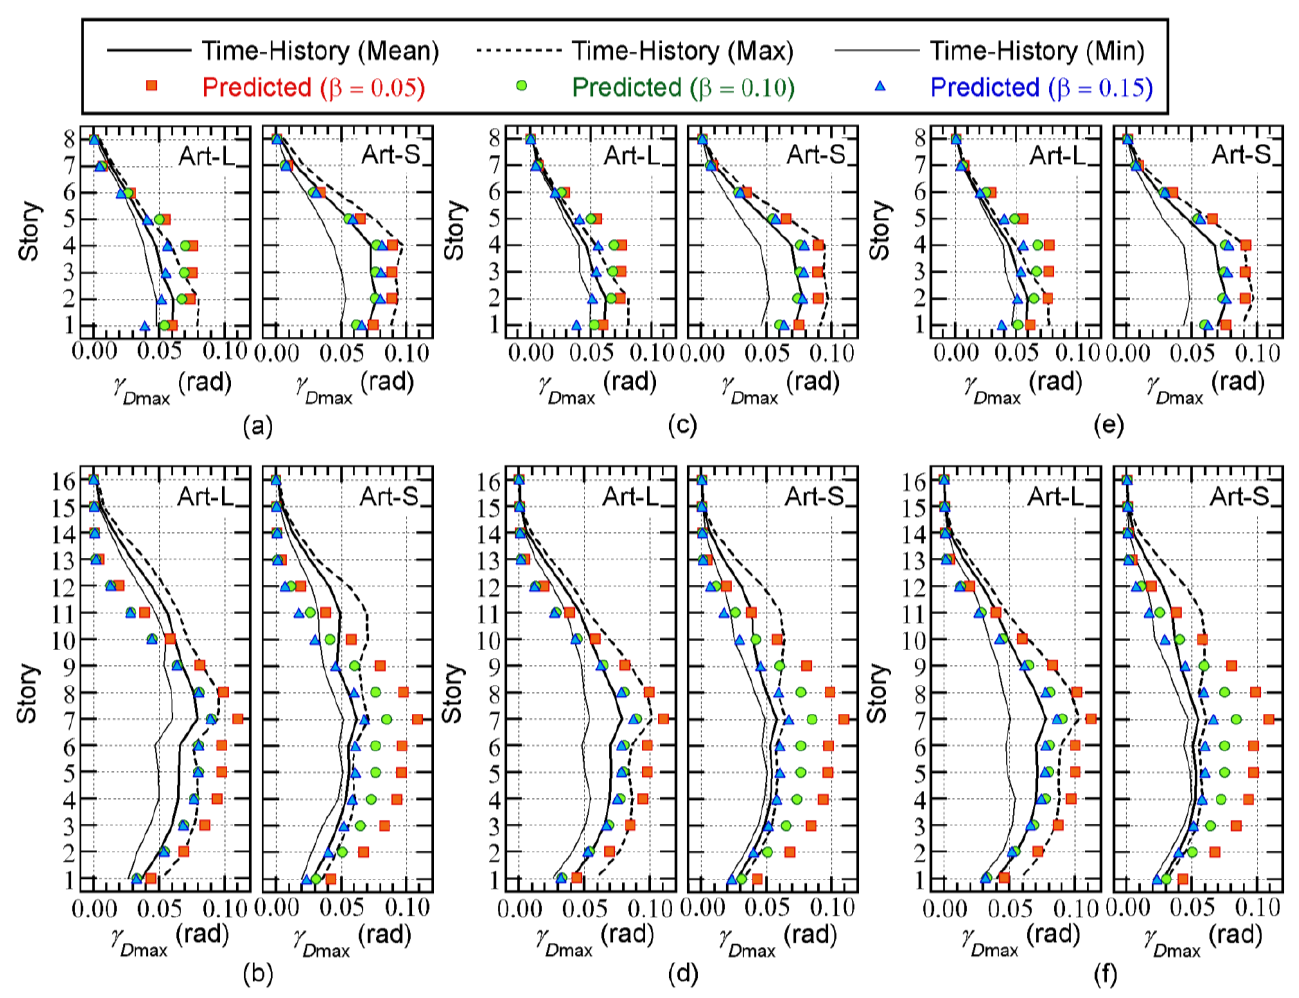
Figure 14. Comparisons of the peak shear strain of the damper panels: ( a ) 8-story model ( ( b ) 16-story model ( h 1 f = 0.00); ( c ) 8-story model ( h 1 f = 0.03); ( d ) 16-story model ( h 1 f = 0.03); ( e ) 8-story model ( h 1 f = 0.05); ( f ) 16-story model ( h 1 f =